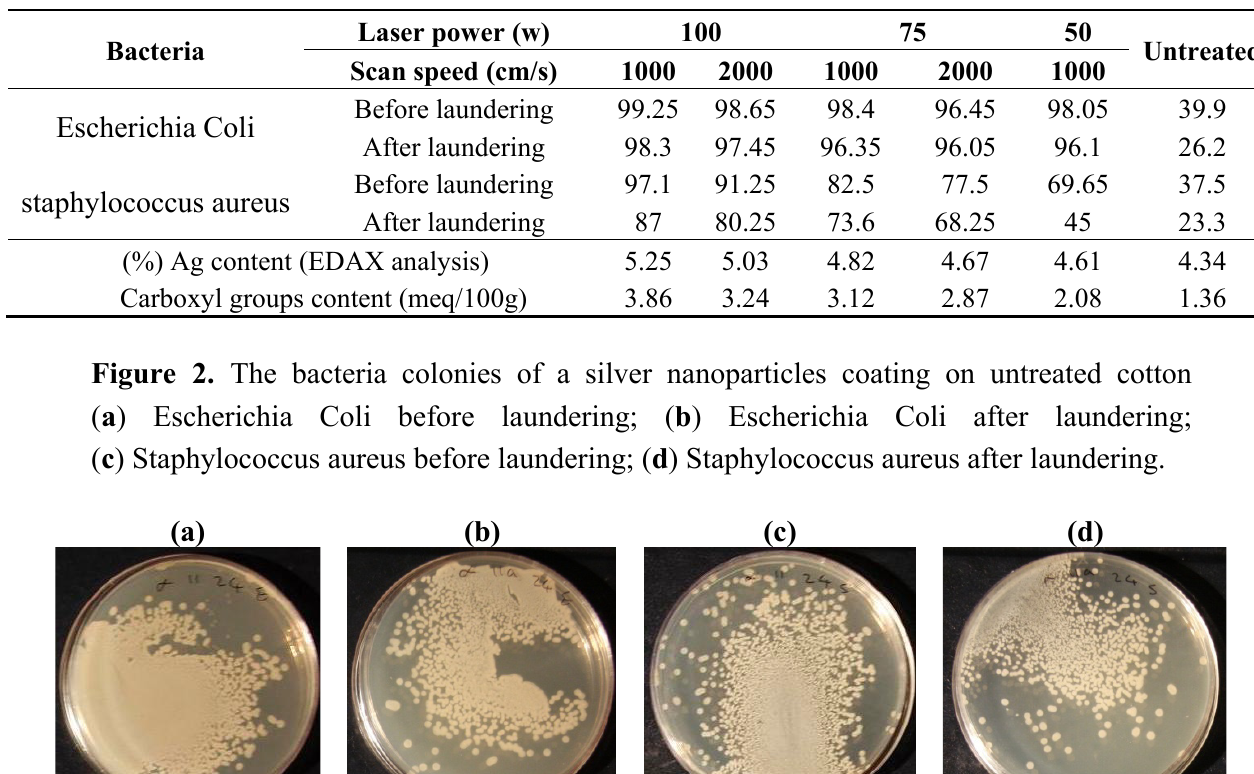
Table 2. Bacteria reduction percentage, Ag content results of EDAX analysis of a silver nanoparticles coating and carboxyl groups’ contents of untreated and laser treated cotton fabrics.